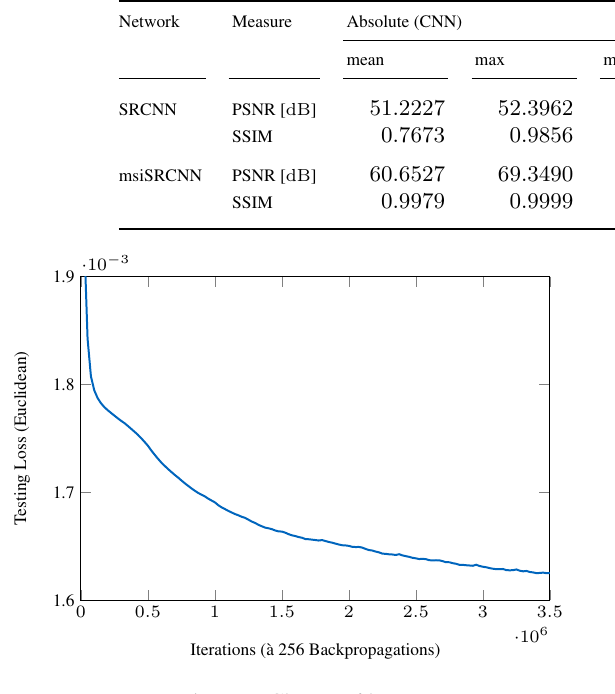
Figure 7: Change of loss